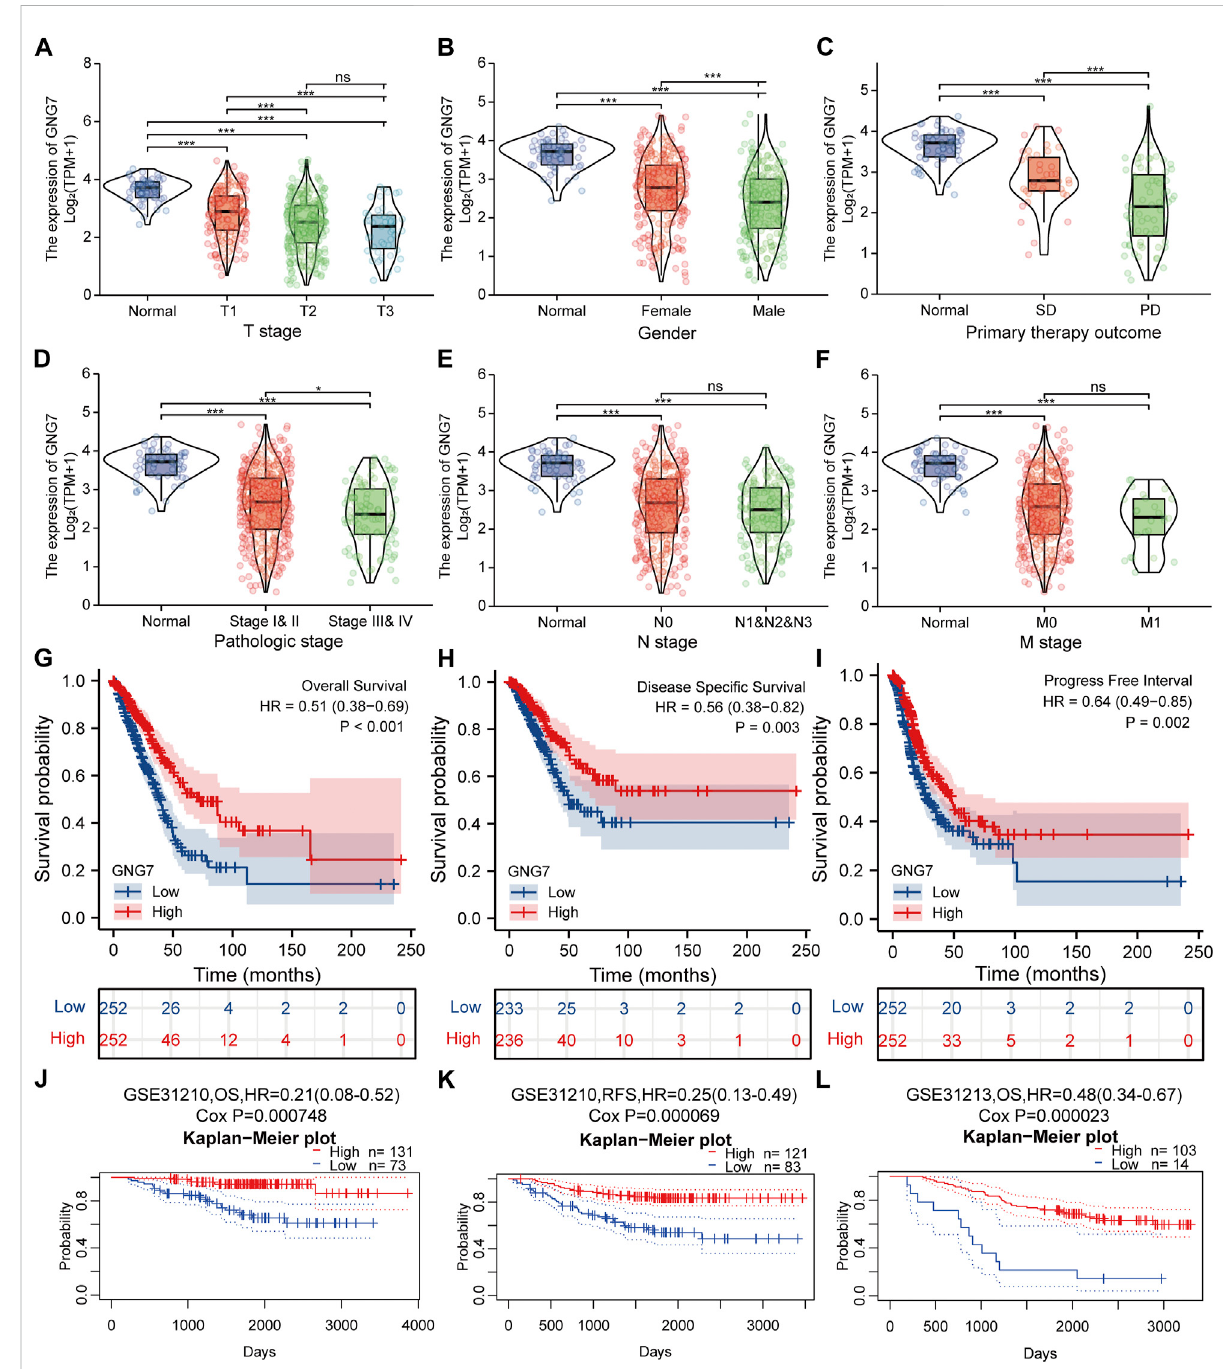
FIGURE 3 Correlation between GNG7 expression and clinicopathological features as well as the prognostic value of GNG7 in LUAD. (A) T stage. (B) Gender. (C) Primary therapy outcome. (D) Pathologic stage. (E) N stage. (F) M stage. ns, no signi fi cant difference, * p < 0.05, ** p < 0.01, *** p < 0.001. (G – I) Survival curves of OS (G) , DSS (H) , and PFI (I) between GNG7-high and GNG7-low expression groups from the TCGA-LUAD dataset. (J – L) Kaplan-Meier survival curve analysis of OS (J) and RFS (K) in a LUAD cohort (GSE31210) as well as OS (L) in a LUAD cohort (GSE31213) from the PrognoScan